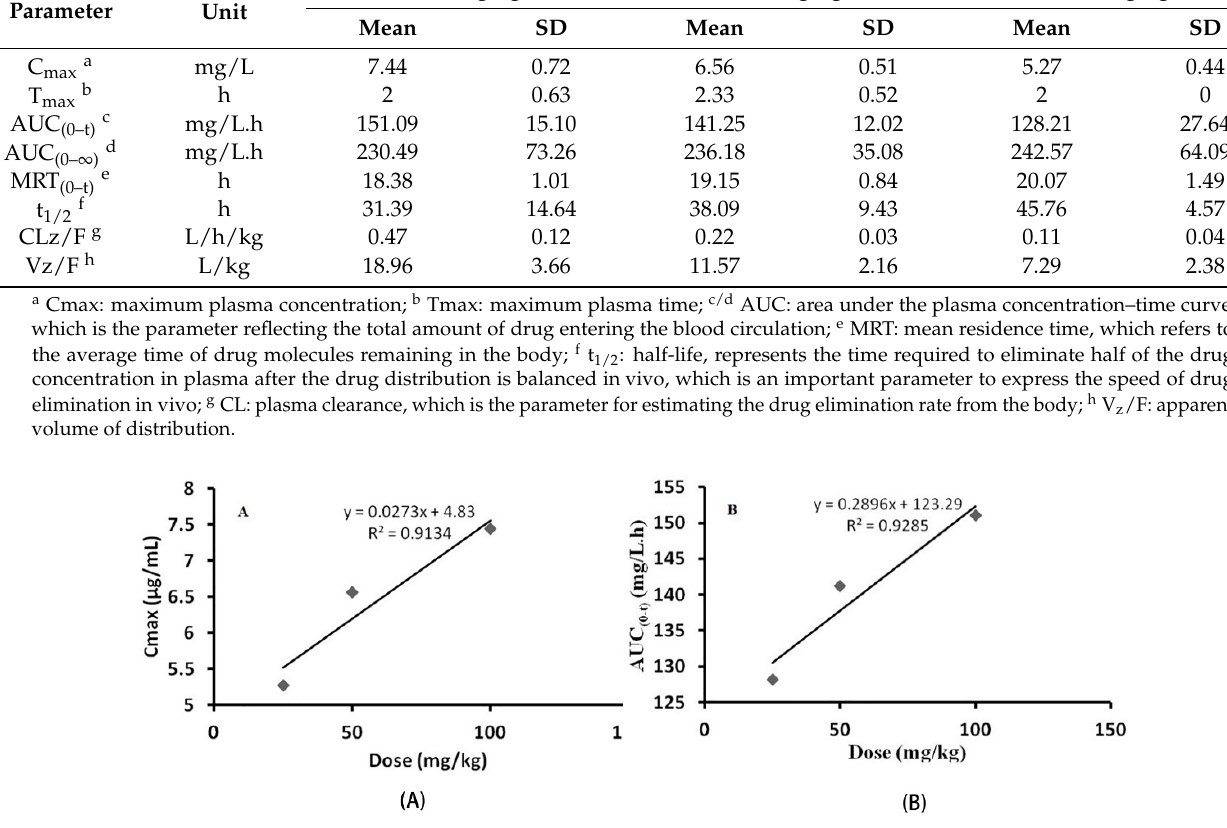
Figure 2. Relationship between C max ( A ), AUC (0–t) ( B ) and different dose after oral administration of LBP-FITC to SD rats.